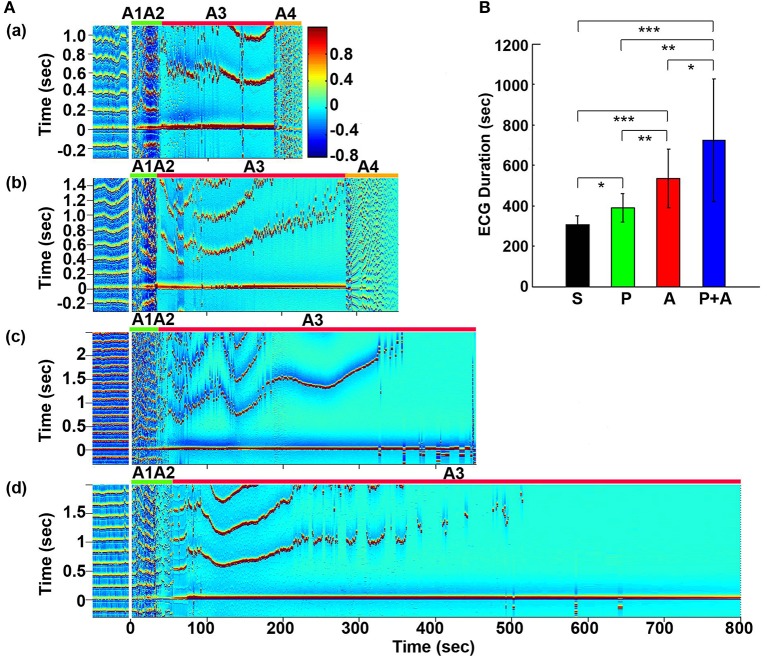
Adrenergic blockade prolongs cardiac survival. (A) Electrocardiomatrix (ECM) display of ECG signals before (50 s) and after asphyxia in four groups of rats: (a) saline, (b) phentolamine, (c) atenolol, and (d) phentolamine plus atenolol. x axis shows time in seconds, y axis shows RR interval (RRI; in seconds), and z axis shows signal strength. Warmer color represents higher signal strength. Asphyxia was induced by CO2 infusion at time 0 s. (B) The mean and SD of ECG signal duration after asphyxia in four groups of rats: S (saline, n = 10), P (phentolamine, n = 7), A (atenolol, n = 8), and P+A (phentolamine plus atenolol, n = 11). Significant differences of ECG signal duration among 4 groups of rats are indicated using asterisks. Error bars denote SD (*p < 0.05, **p < 0.01, ***p < 0.001).